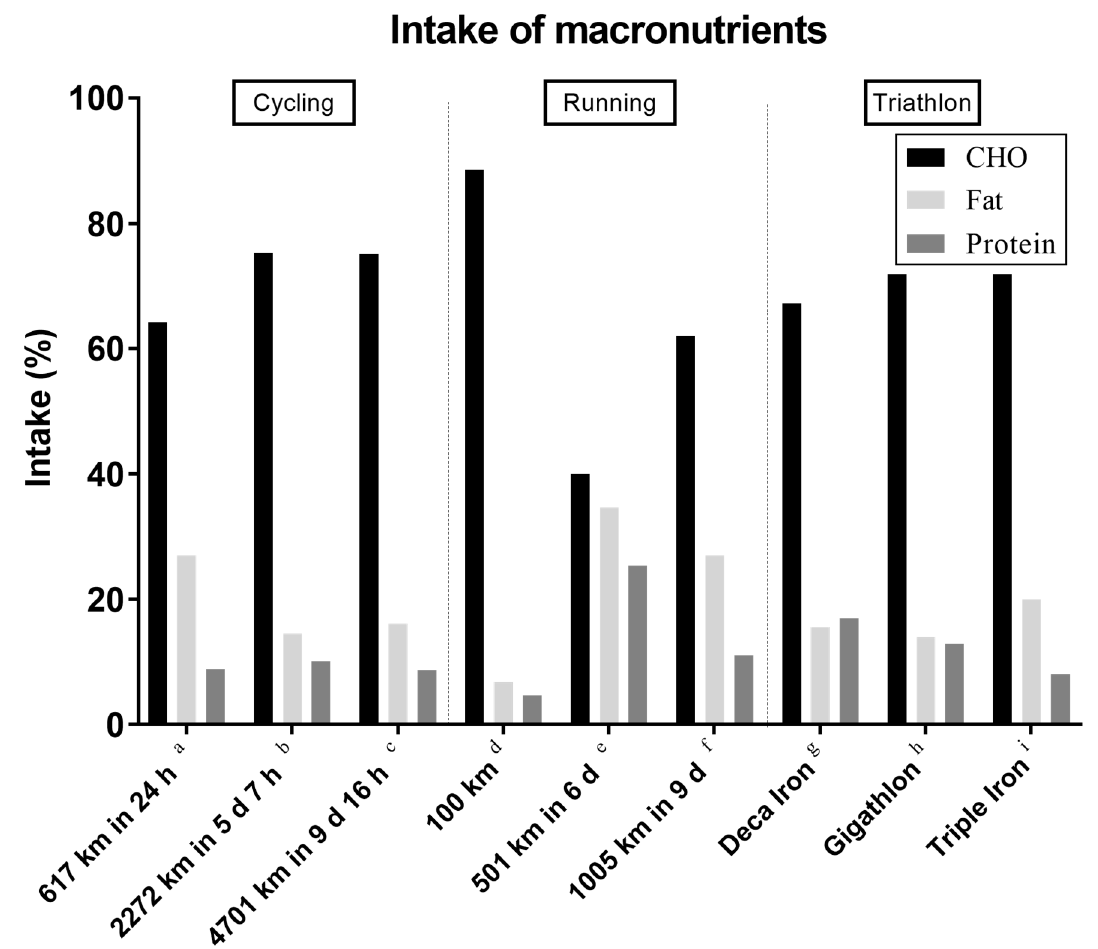
Figure 5. Percentage intake of macronutrients. a = [28], b = [32], c = [11], d = [104], e = [35], f = [105], g = [106], h = [41], i = [40].